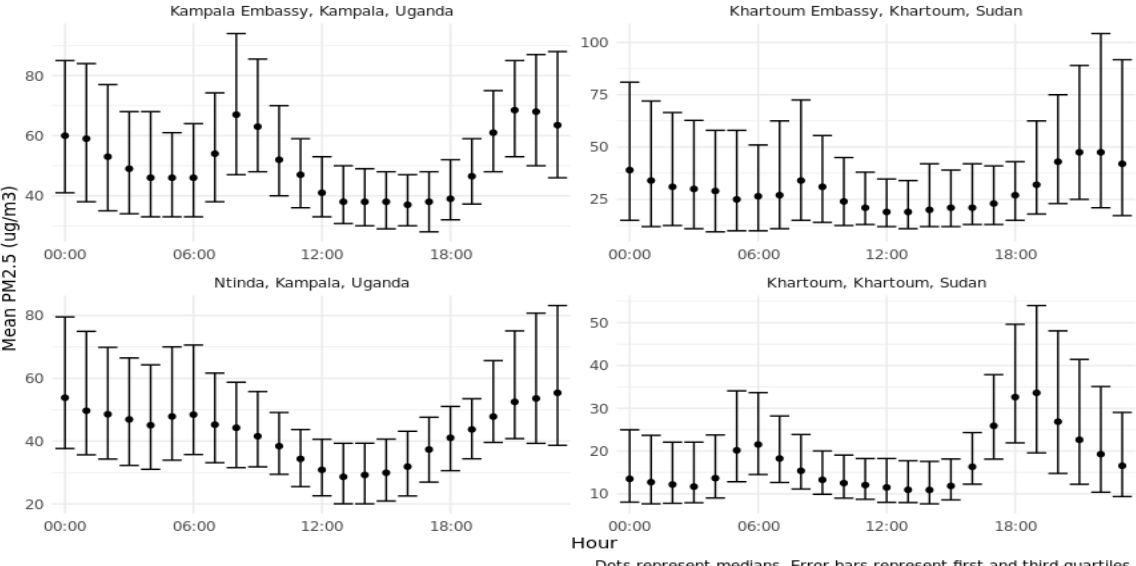
Figure 7. Comparison of one day plots showing the performance of the PurpleAir II SDs versus the US Embassy BAMs at Kampala (Uganda) ( left ) and Khartoum (Sudan) ( right ). The top figures are the Embassy BAMs, while the bottom ones are the nearby PurpleAir devices.